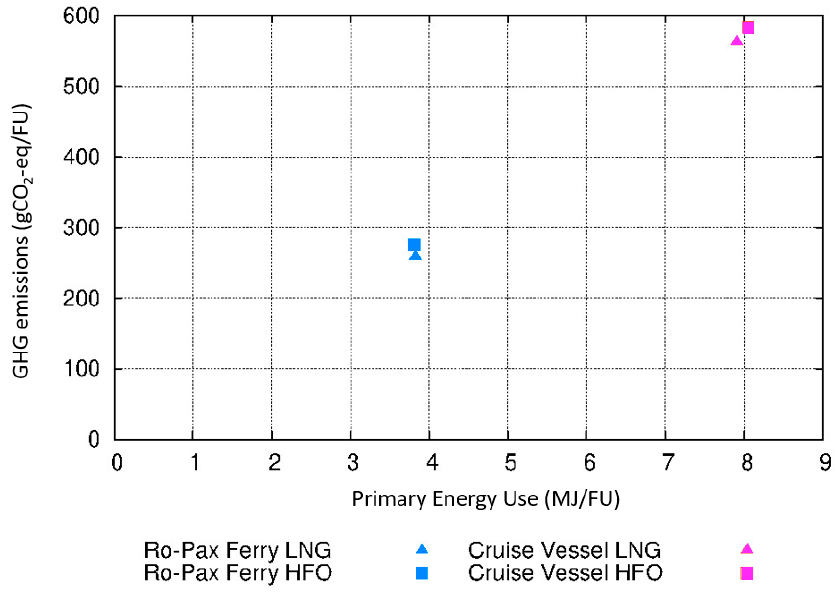
Figure 8. Tank-to-propeller GHG emissions and PEU per pkm for four-stroke engines.